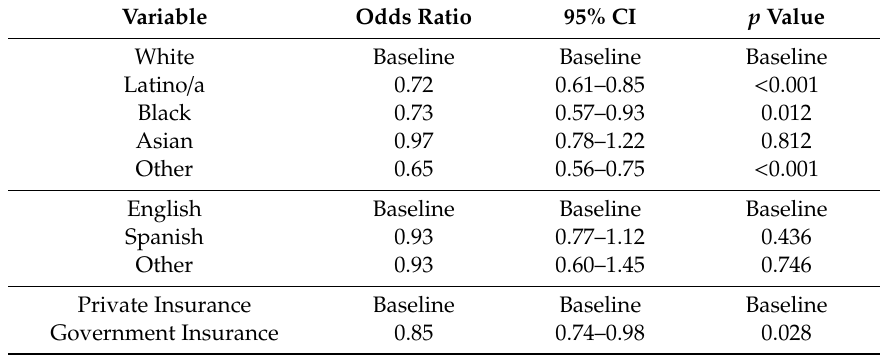
Table 4. Logistic regression for the primary outcome use of caudal regional